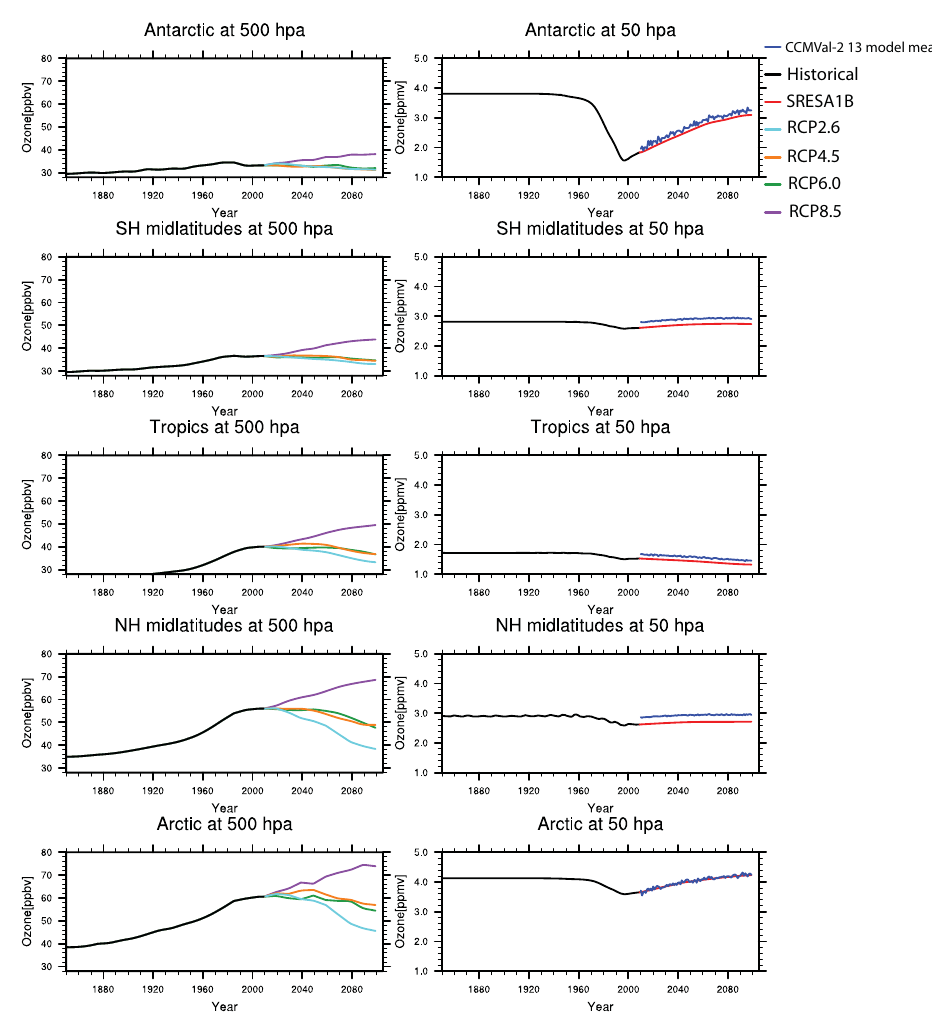
Fig. 3. Annual time series at 500hPa (left) and 50hPa (right) in various regions (spring-time Arctic and Antarctic, annual mean northern and southern midlatitudes, annual mean